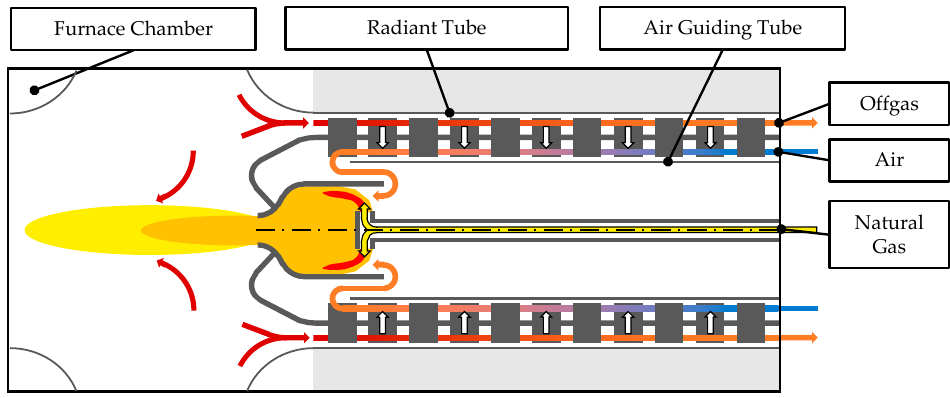
Figure 3. Flow paths through a radiant tube integrated self-recuperative burner.